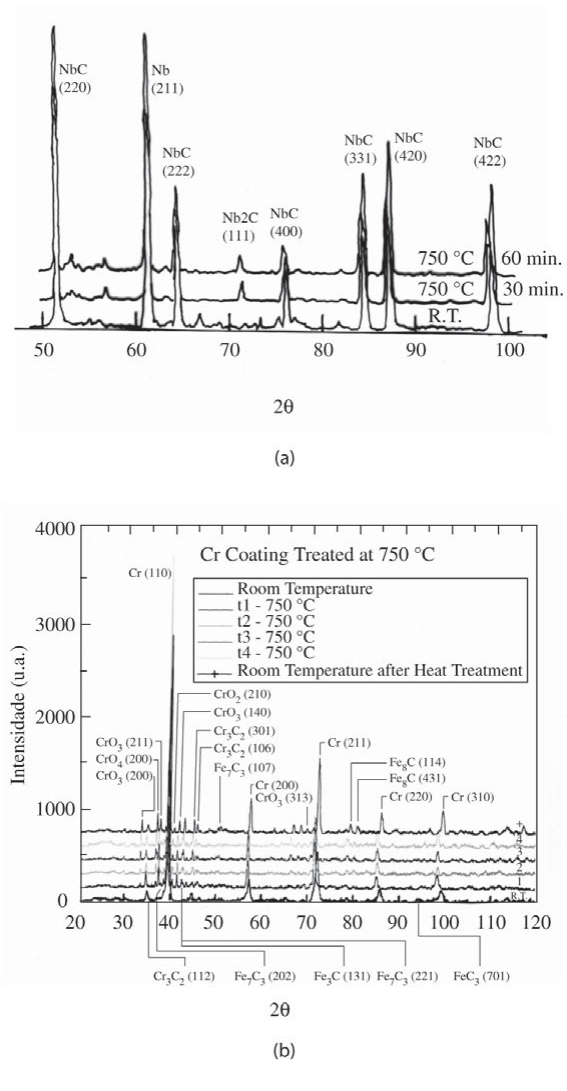
Figure 1. X-ray diffraction patterns at 750 °C: a) Nb; b) Cr. In both cases the pattern corresponding to the sample at room tem- perature (R.T.) is also plotted for